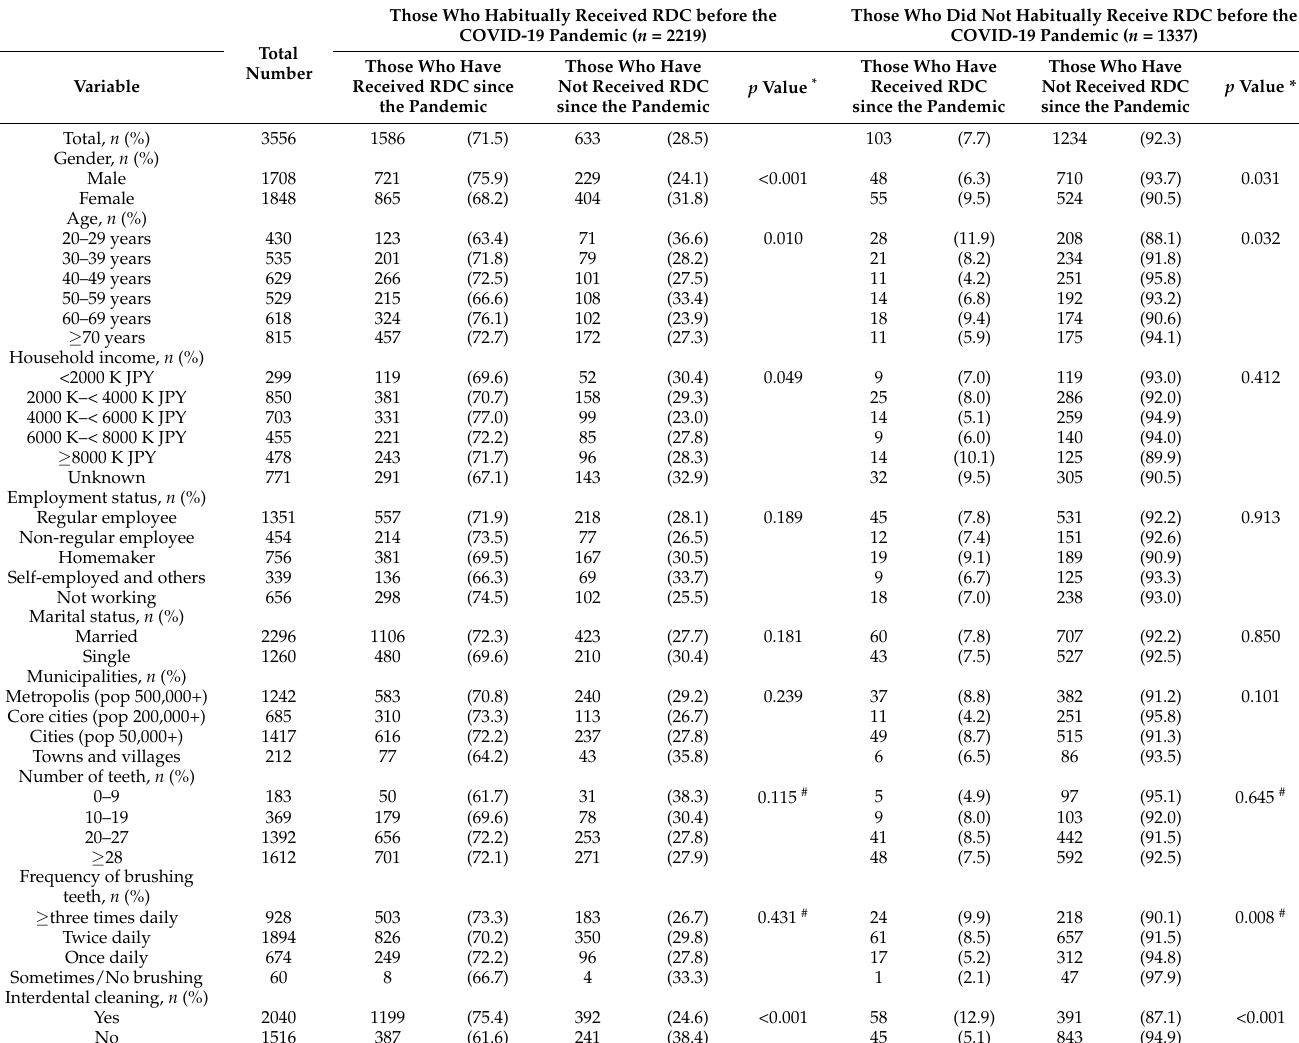
Table 1. Relationship between receiving RDCs owing to the COVID-19 pandemic and study partici- pants’